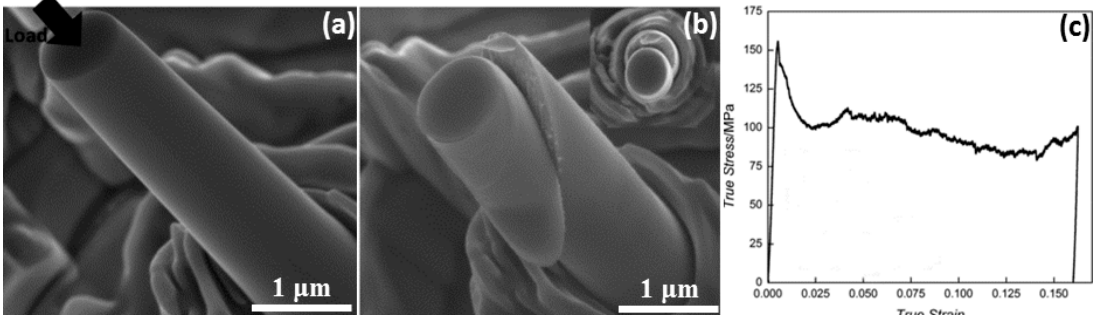
Figure 6. ( a ) SEM image of an as-fabricated pillar before uniaxial compression with the direction of applied load shown by the black arrow. ( b ) Post-deformation SEM image of the same pillar taken along the same directions as in (a), which shows that the upper grain sheared off from the lower grain along the grain boundary plane. Wavy features can be seen on the exposed grain boundary plane extending periodically from the near side of the pillar to the far side. The inset in the upper right corner shows a top-down view of the same pillar. ( c ) Stress-strain data of the same pillar collected during the compression experiment. The yield corresponds to the maximum peak stress at the strain of 0.5%, after which it rapidly softens, and plastic flow commences at a gradually decreasing stress to the final unloading strain of ~16% [36] ( Reprinted from Small, Copyright 2014, with permission from John Wiley and Sons ).